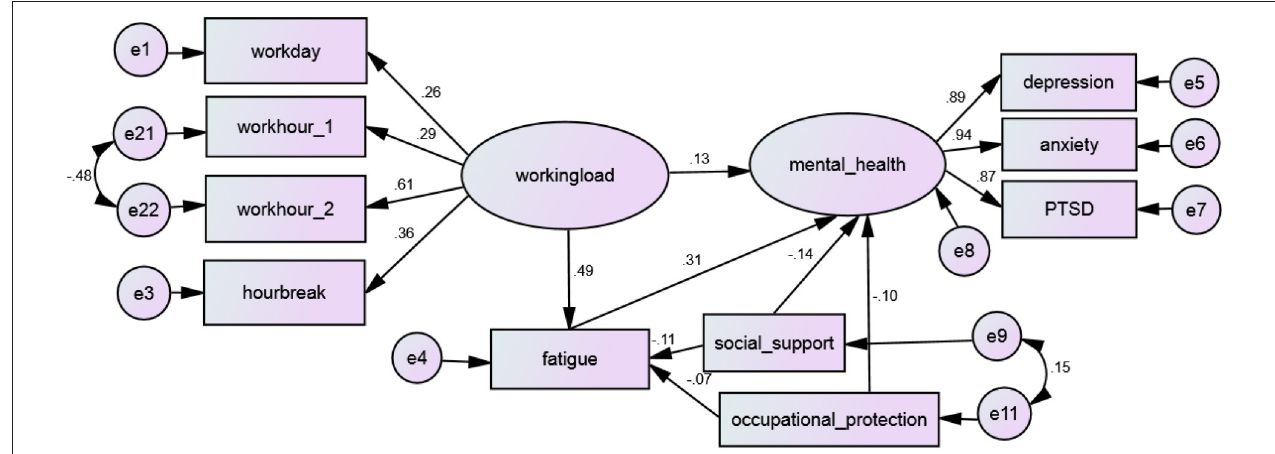
FIGURE 1 | Structural equation modeling of fatigue as mediator of mental